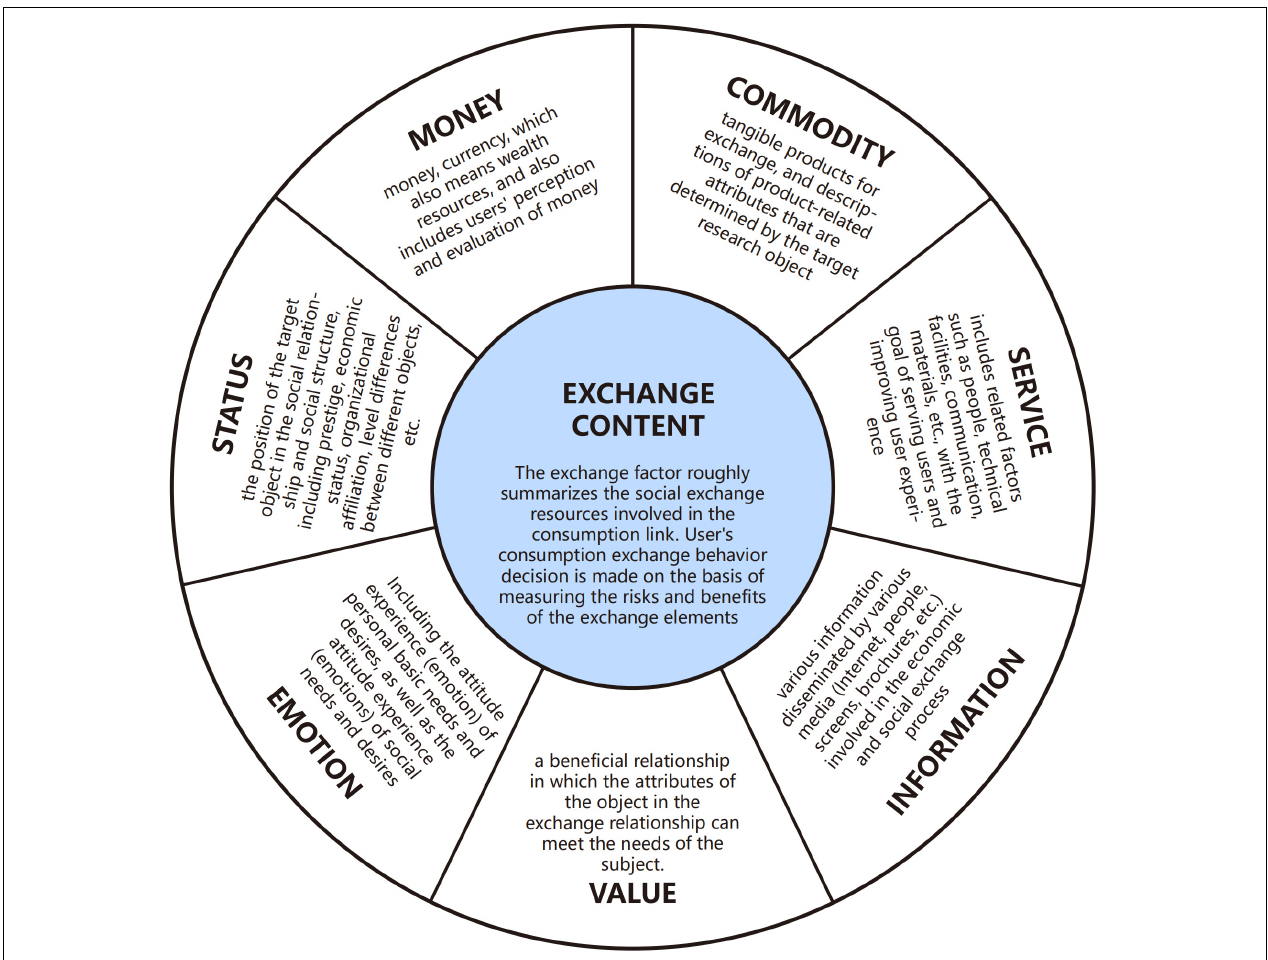
FIGURE 4 | Social exchange content block